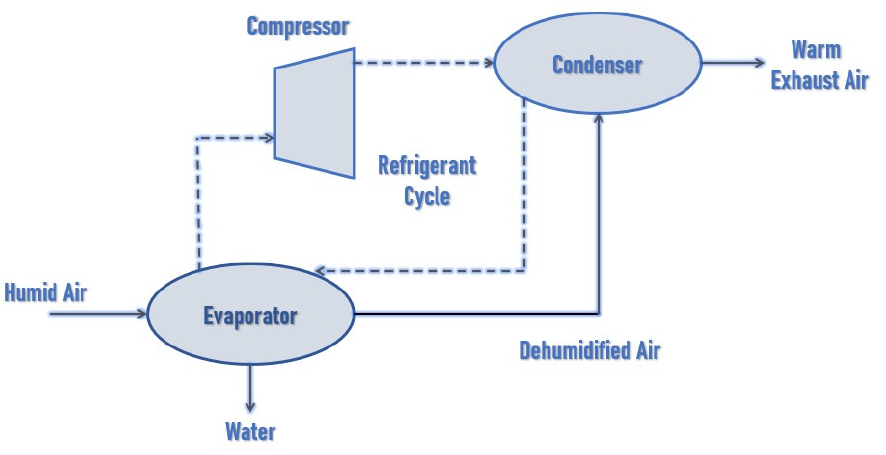
Figure 3. Block diagram of water extractor [22].